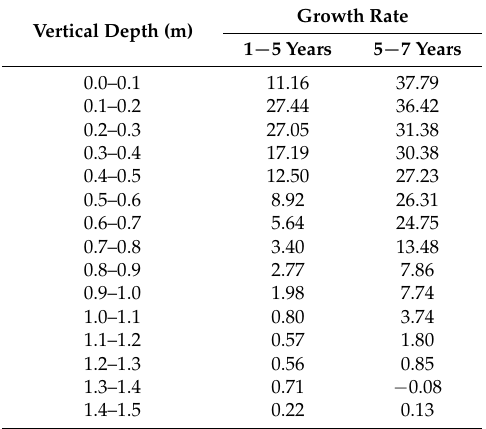
Table 5. The growth rate of total root biomass in each soil layer in the vertical direction.